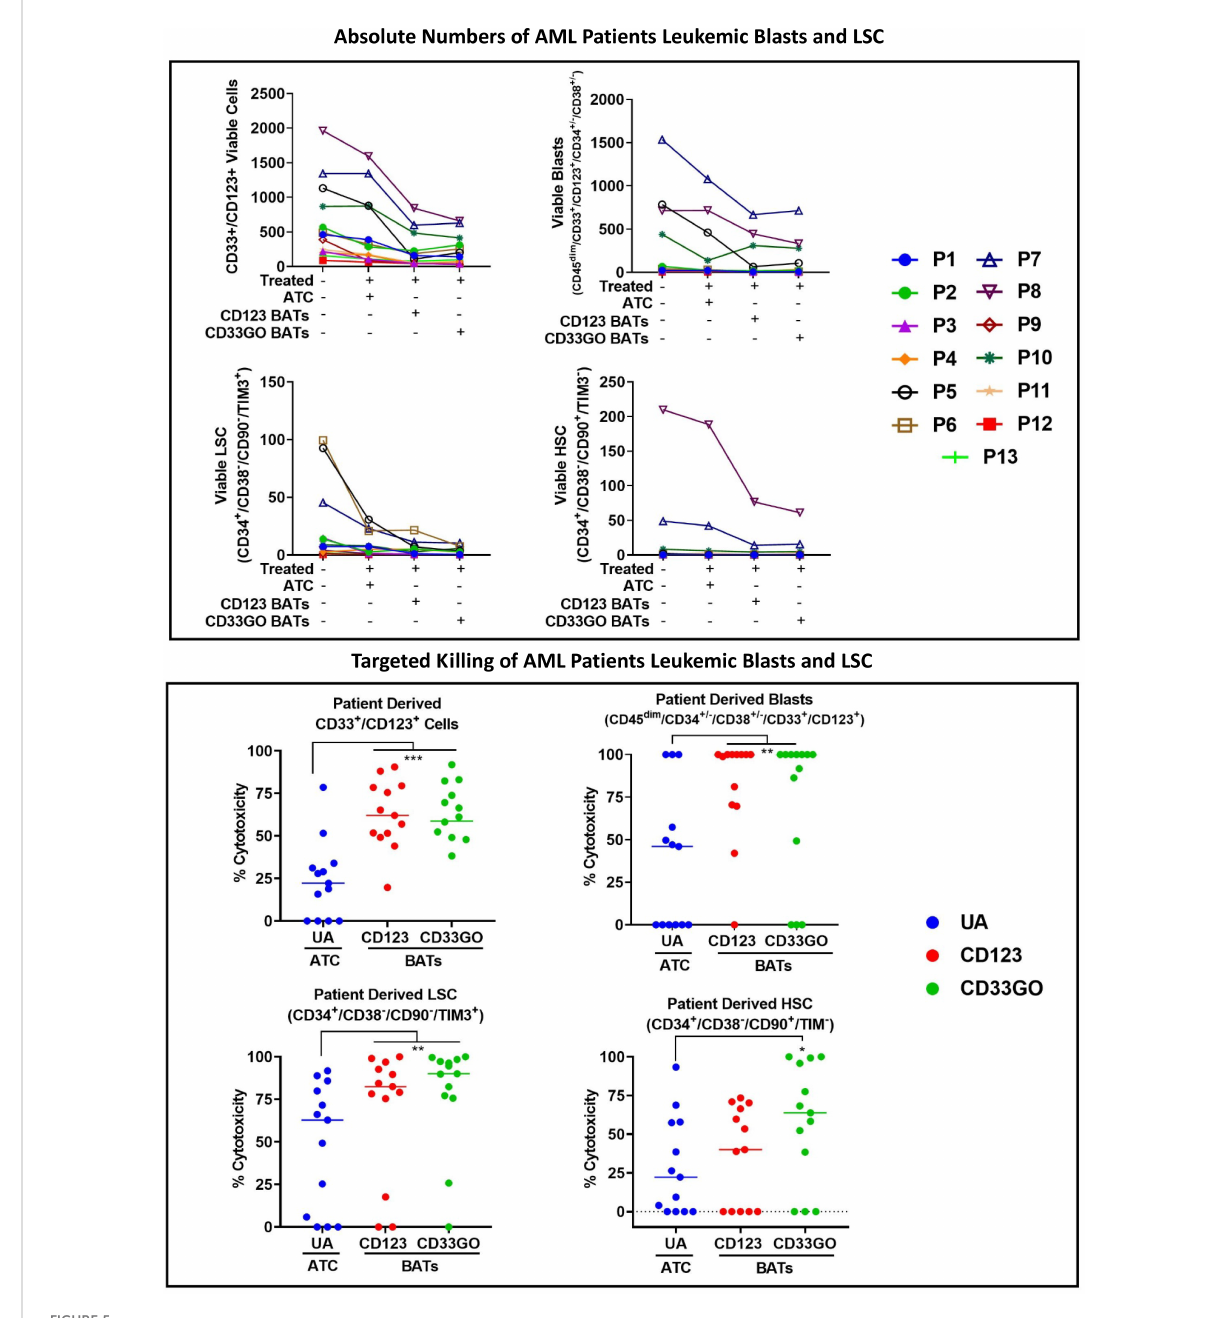
FIGURE 5 Cytotoxicity against Blasts and LSC by CD33GO and CD123 BATs. Upper panel shows the absolute numbers of remaining CD33+/CD123+ cells, leukemia precursors CD34+/CD38-, CD33+/CD34+/CD38- leukemic blast population, CD33+/CD123+/ CD34+/CD38-/CD90-/TIM3+ LSC and CD33+/CD123+/CD34+/ CD38-/CD90+/TIM3- HSC populations after targeted killing by ATC, CD33GO BATs or CD123 BATs compared to untreated PBMC. Lower panel shows the cytotoxicity against CD33/CD123 expressing cells by CD33GO- (p=0.0007) and CD123 BATs (p=0.0002); cytotoxicity against blast population by CD33GO- (p<0.005) and CD123 BATs (p<0.002); cytotoxicity against LSC by CD33GO- (p<0.006) and CD123 BATs (p<0.002) and cytotoxicity against HSC by CD33GO BATs (p<0.05) compared to unarmed ATC in the in vitro killing assay using Wilcoxon signed-rank test (* = p<0.05; ** = p<0.005; *** =